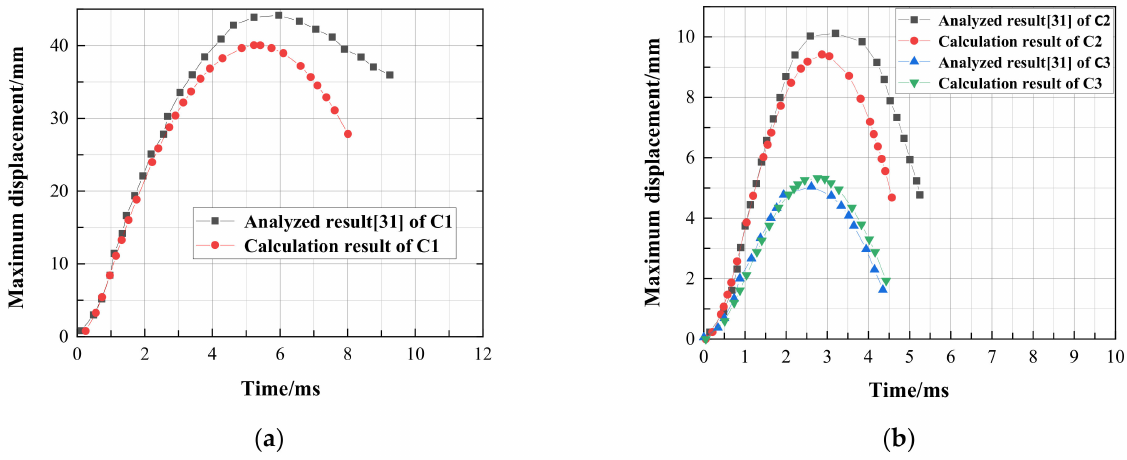
Figure 6. Comparison between the simulation calculation and ESDOF calculation result. ( a ) Com- parison of time–displacement curves for C1. ( b ) Comparison of time–displacement curves for C2 and